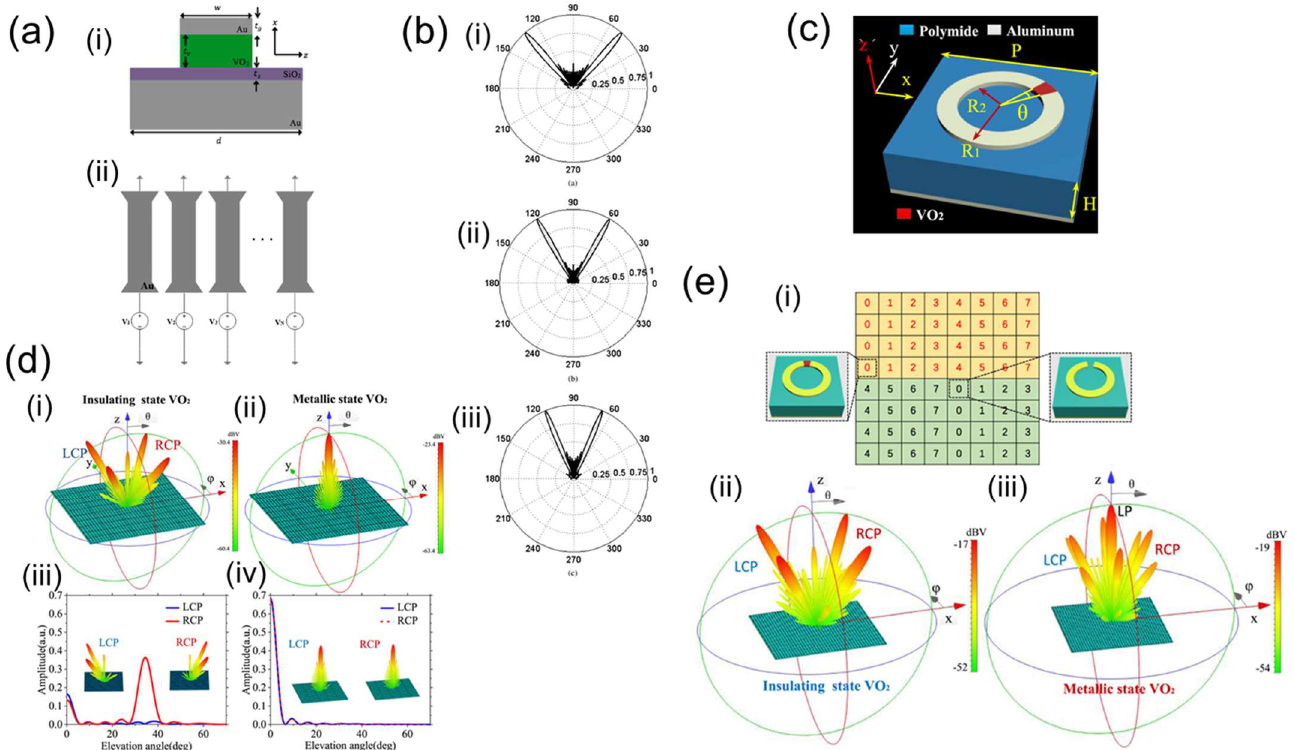
Figure 18. ( a ) Cross−sectional ( i ) and top views ( ii ) of the metasurface element [144]. ( b ) ( i − iii ) Normalized far-field radiation patterns of the reconfigurable beam splitter under three voltage configurations [144]. ( c ) Schematic diagram of the combined optical antenna. Reprinted from [145], Copyright 2020, with permission from Elsevier. ( d ) Far−field patterns and normalized amplitudes of the metasurface with VO 2 in the insulating ( i , iii ) and metallic ( ii , iv ) states. Reprinted from [145], Copyright 2020, with permission from Elsevier. ( e ) ( i ) Schematic diagram of a period in a hybrid metasurface and the far-field pattern of the metasurface with VO 2 in insulating ( ii ) and metallic ( iii ) states. Reprinted from [145], Copyright 2020, with permission from Elsevier.